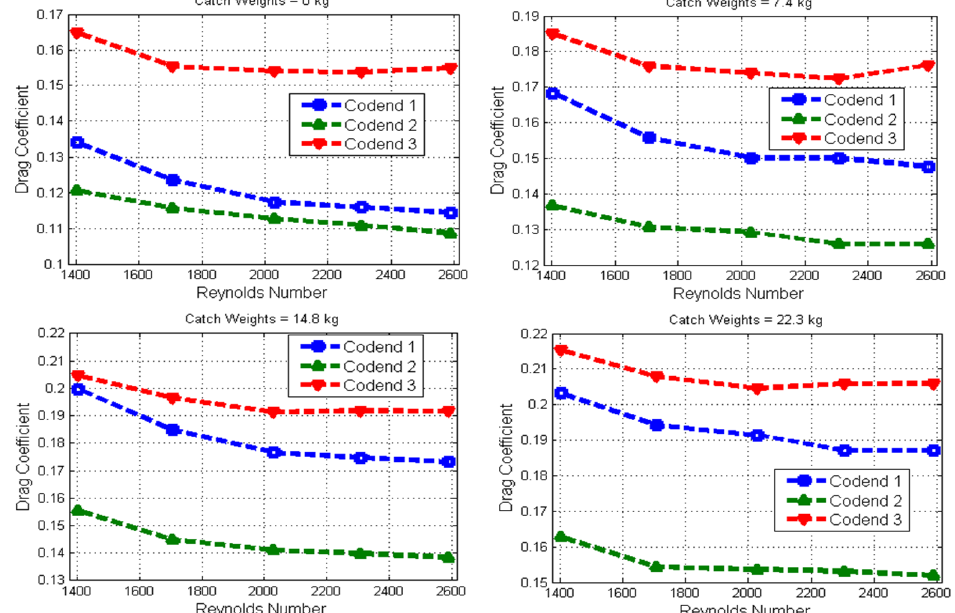
Figure 8. Drag coefficient of the three codends at different catch weight as function of Reynolds number calculated with twine diameter.